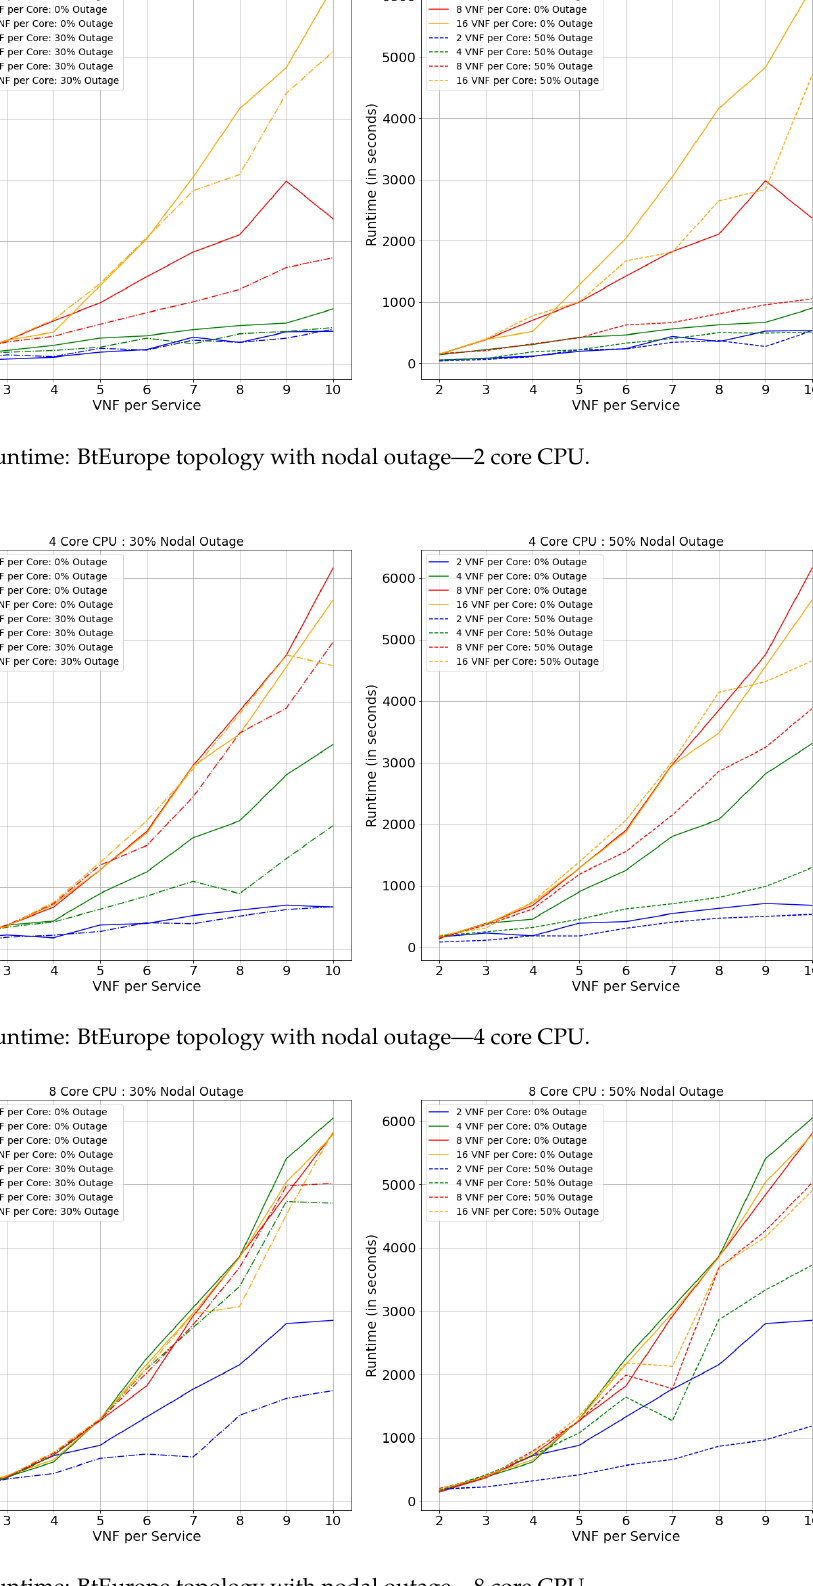
Figure 27. Runtime: BtEurope topology with nodal outage—8 core